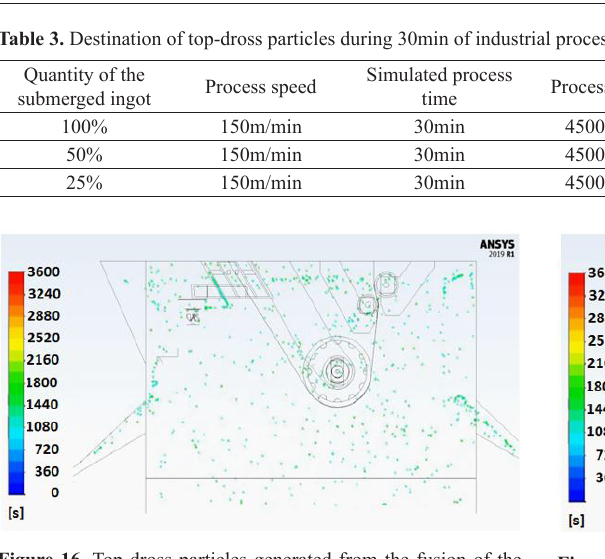
Figure 17. Top-dross particles generated from the fusion of zinc ingot, immersed 25%, still resident and dispersed in the galvanizing bath after 30 min (1800 s) of industrial process simulation.